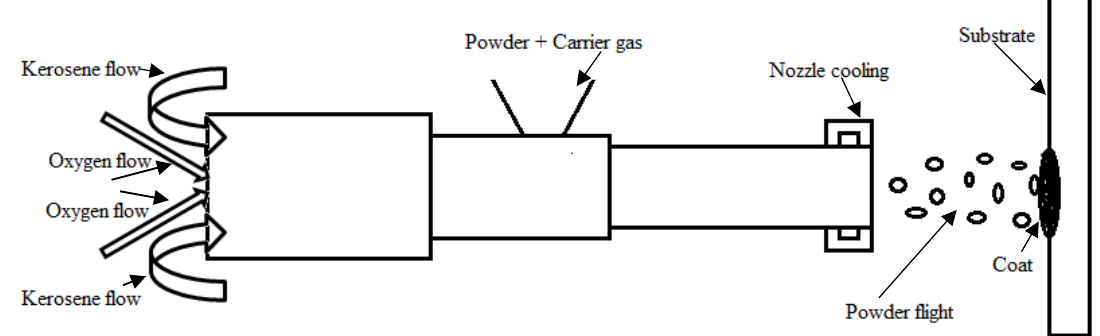
Figure 1. Schematic diagram of HVOF process for producing coating on mild steel sample. Table 2. Process parameters for coating fabrication on mild steel samples.